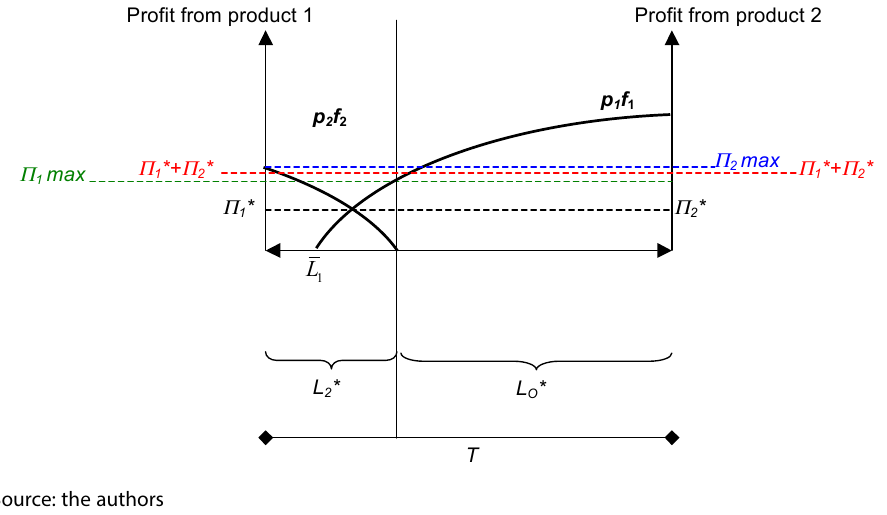
Figure 3. Graphical representation of labour allocation for a part-time farmer allocating much time off